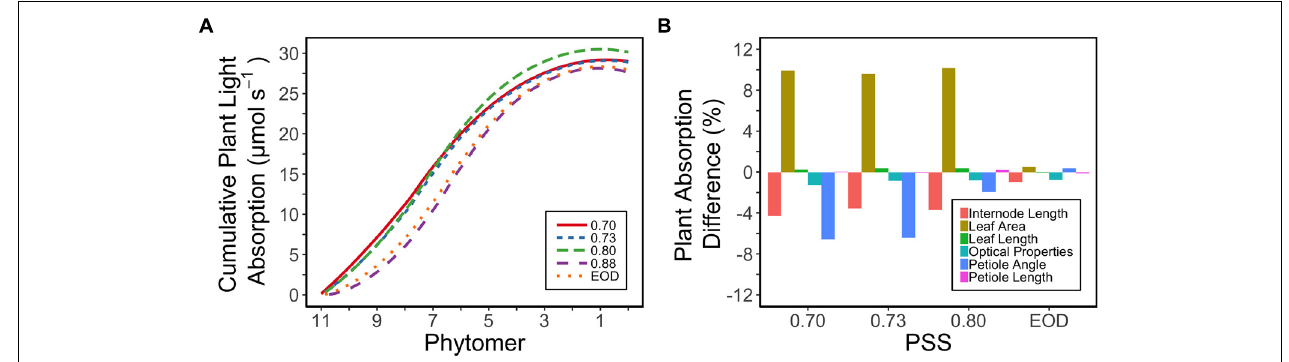
FIGURE 5 | (A) Calculated cumulative (starting from the plant top, i.e., Phytomer 11) light absorption of tomato plants per phytomer (leaf + internode + petiole) in relation to four levels of PSS and an EOD-FR treatment in EXP1 (total light intensity of 150 µ mol m − 2 s − 1 ). Plants had been grown for 4 weeks at the different light treatments, separated by vertical screens. Calculations were done using a functional-structural plant model based on the average plant morphological and optical parameters of each treatment. The phytomers were counted acropetally where phytomer 1 represents the hypocotyl and two cotyledons. (B) Relative impact of the morphological parameters (internode length, petiole angle, leaf area, leaf length, petiole length) and optical properties of the leaves (transmittance, reflectance) on the calculated plant light absorption. Plants with PSS 0.88 were taken as reference. Light absorption of the plants was calculated by replacing the parameter values of plants with PSS 0.88 by parameter values taken from plants with PSS 0.70, 0.73, 0.80, and EOD. After one parameter was changed, the plant absorption was compared to the original absorption of the plants with PSS 0.88.